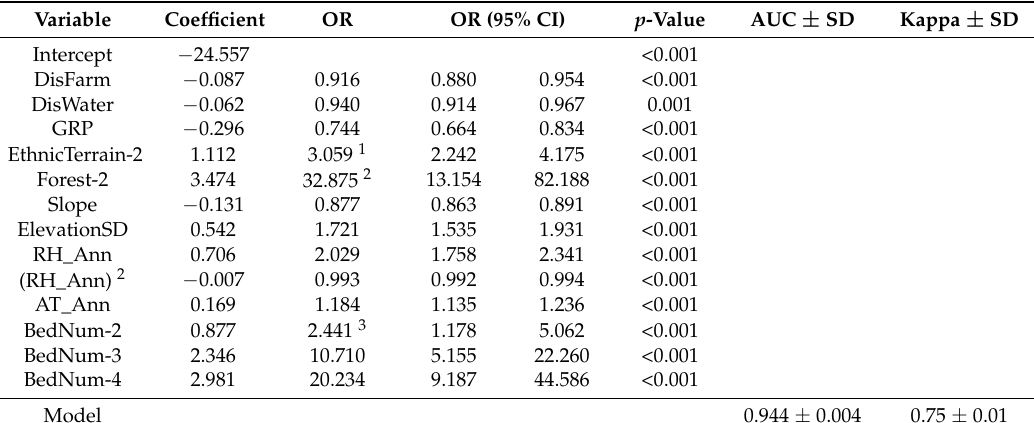
Table 3. Summary of the multiple logistic regression models on the risks for bacillary dysentery in southwest China.